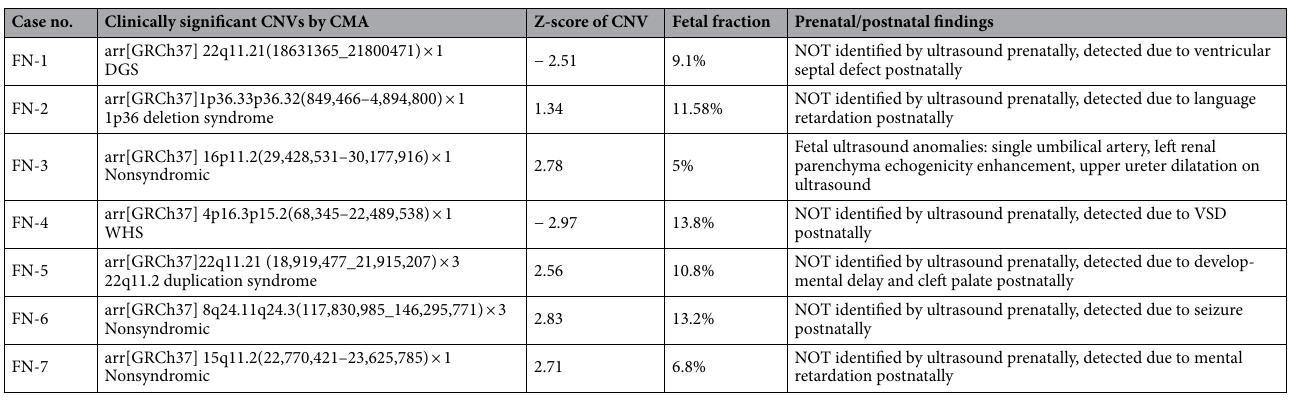
Table 7. Seven cases with false negative NIPT results missed by NIPT-Plus with validation. DGS DiGeorge syndrome, WHS Wolf-Hirschhorn syndrome, FN false negative, VSD ventricular septal